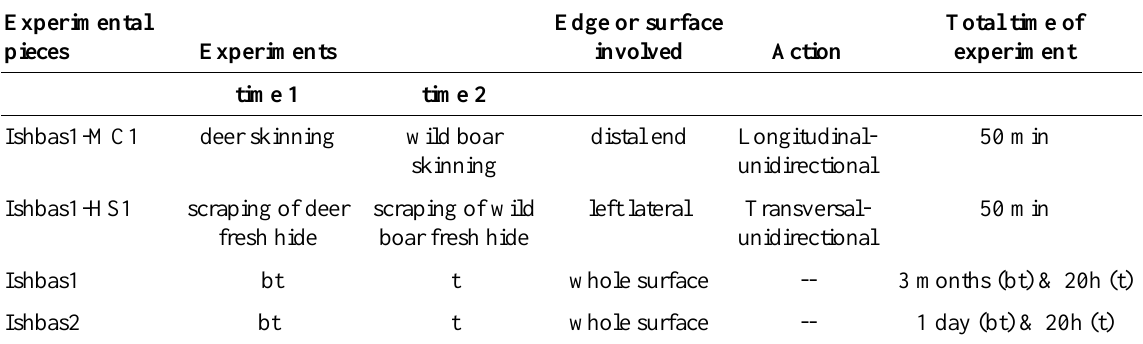
Table 1. Experimental pieces and method of use in the experiments. Abbreviations: bt - bear trampling; t -